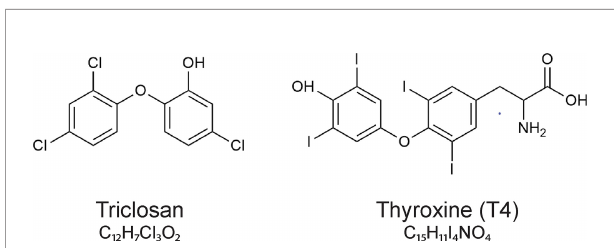
FIGURE 2 | The chemical structures of triclosan (5-chloro-2-(2,4- dichlorophenoxy)phenol)) and the thyroid hormone thyroxine